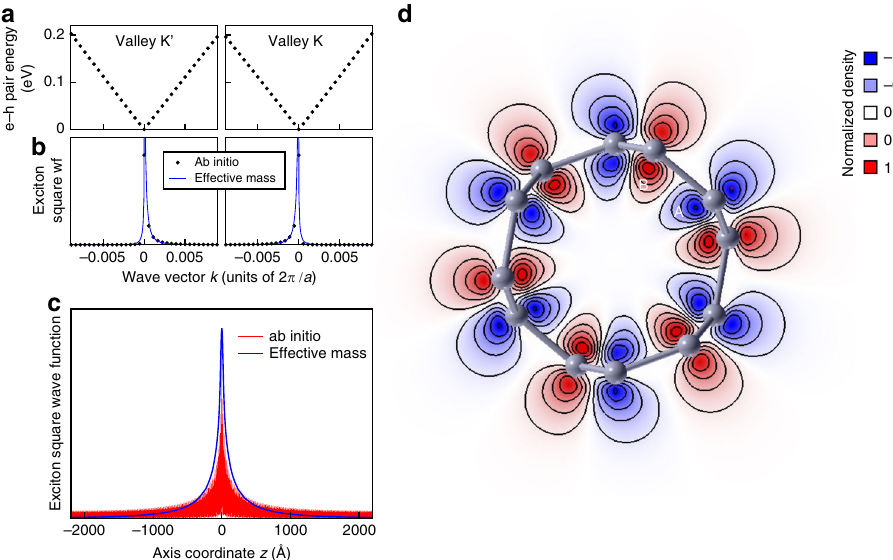
Fig. 3 Wave function of the lowest-energy exciton of the (3, 3) tube. a GW excitation spectrum of free e – h pairs with zero center-of-mass momentum in the two Dirac valleys. b Square modulus of the triplet exciton wave function vs momentum k . Both fi rst-principles (dots) and effective-mass (solid lines) probability weights accumulate asymmetrically close to Dirac points. The effective-mass model includes the dressed long-range interaction, the short- range intervalley exchange, and the small asymmetry of Dirac cones (cf. Supplementary Notes 1 – 3; a previous phenomenological theory 80 by one of the authors, which ignored the key role of long-range interaction, is ruled out by the present work). c Square modulus of the triplet exciton wave function vs e – h distance along the axis, z , according to fi rst-principles (red curve) and effective-mass (blue curve) calculations. The Bohr diameter is larger than 2 μ m. d Cross-sectional contour map of the transition density of the singlet exciton, ϱ tr ( r ), obtained from fi rst principles. The blue/red color points to the de fi cit/ surplus of charge, the isolines are equally spaced, the normalization of ϱ tr ( r ) is such that its maximum value is one, and letters label